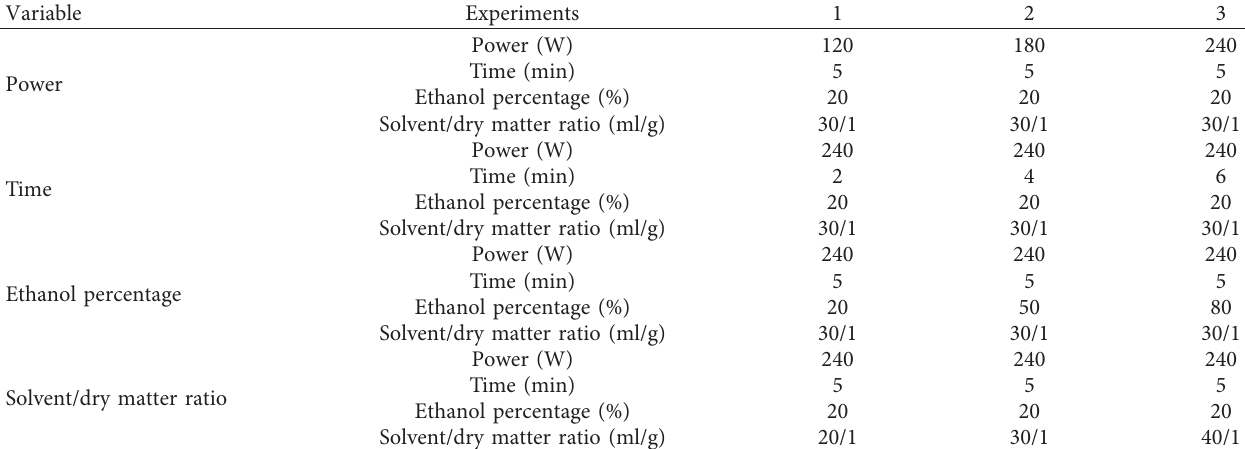
Table 1: Screening